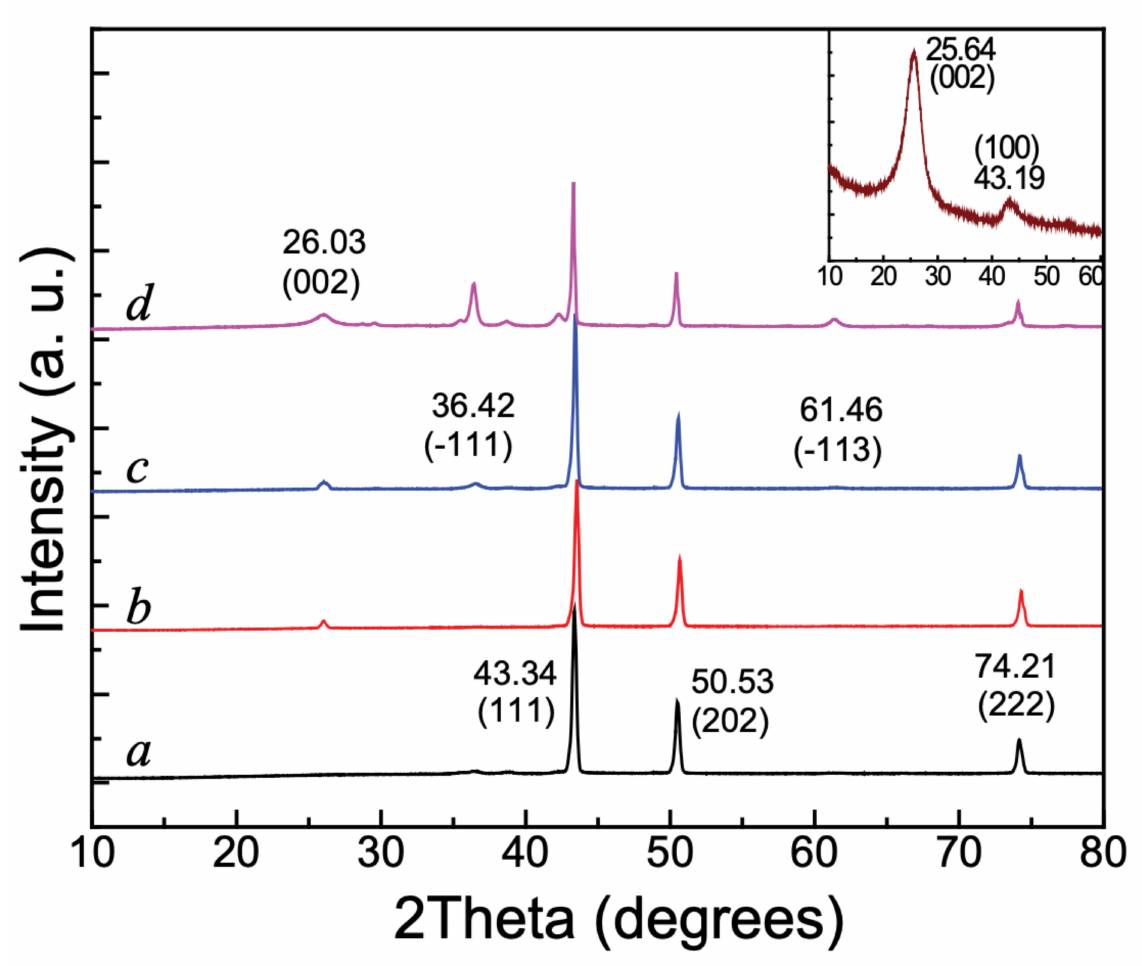
Figure 3. X-ray diffractometric analysis (XRD) plots of ( a ) pure CuO, ( b ) CuOSC-1, ( c ) CuOSC-2, and ( d ) CuOSC-3. The inset shows the XRD pattern of pure